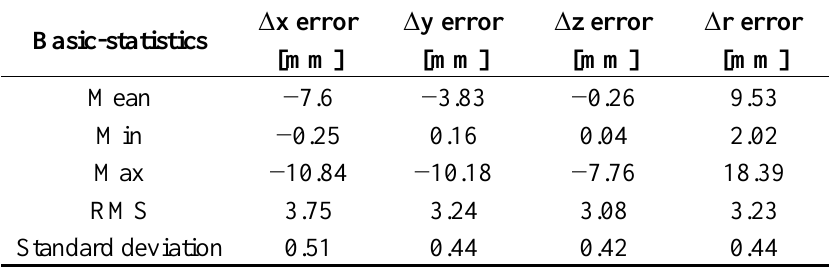
Table 2. Basic statistic results for modulus analysis of